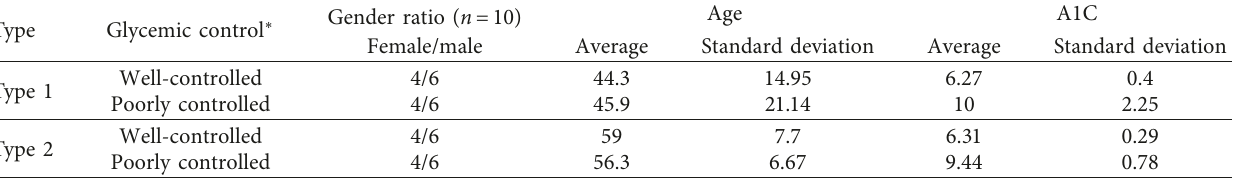
Table 1: Demographic data of subjects.